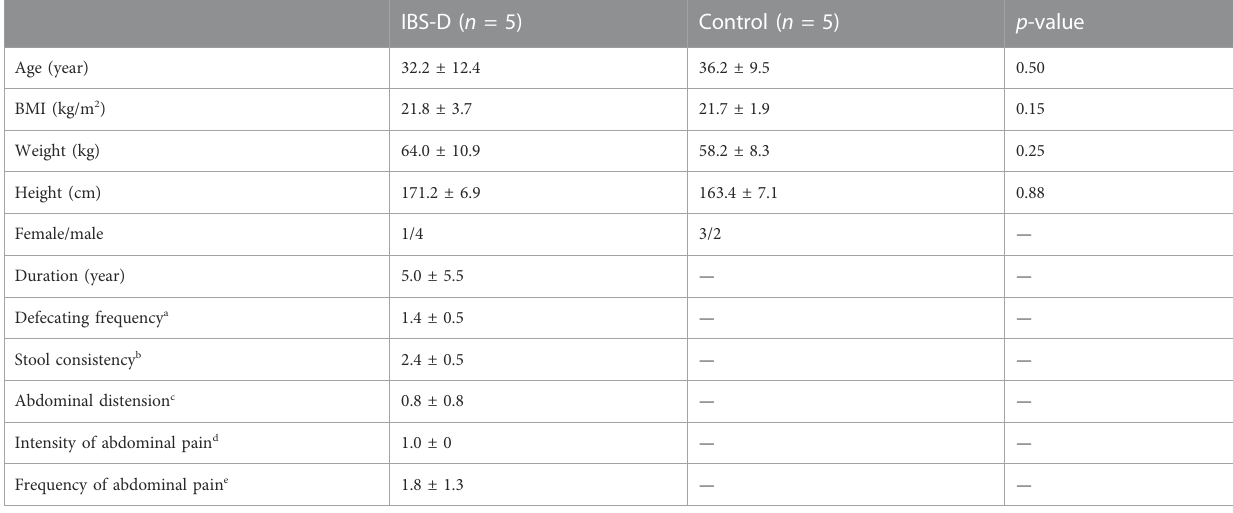
TABLE 1 The clinical data of